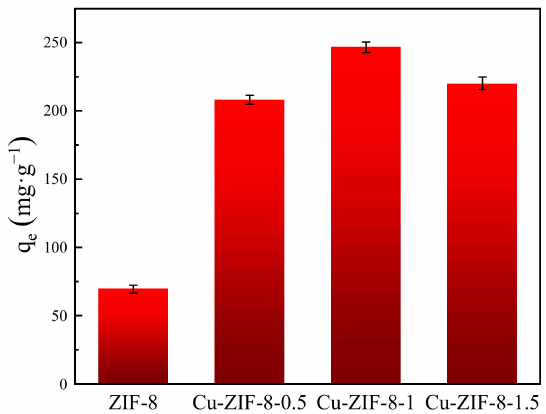
Figure 3. Adsorption capacity at different loadings ( c 0 = 270 mg · L − 1 ).